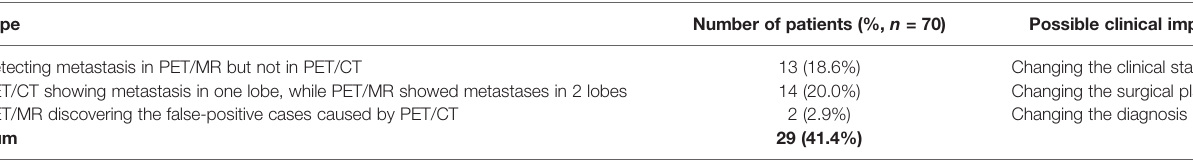
TABLE 5 | Possible clinical impact of the delayed PET/MR in this study.